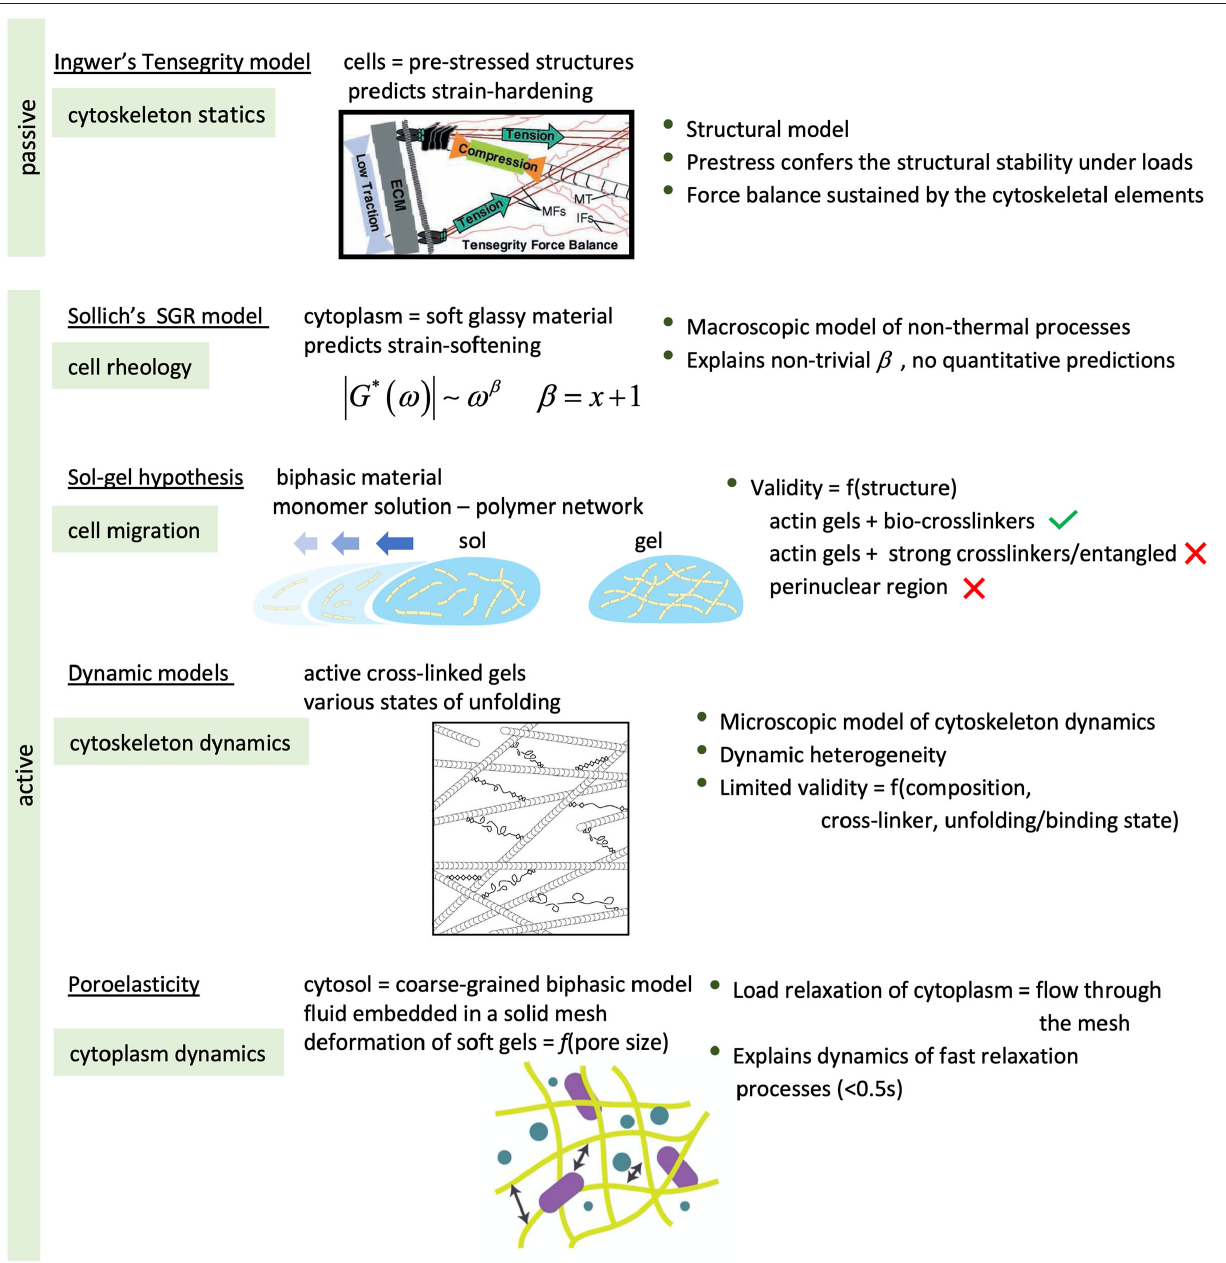
FIGURE 12 | Summary of some of the theories to understand the behavior of living cells, in particular cell components, under mechanical stress or deformation. [Artworks of tensegrity, dynamic models and poroelasticity reproduced from (Ingber, 2003), (Hoffman et al., 2007), and (Hasse and Pelling, 2015), respectively, with